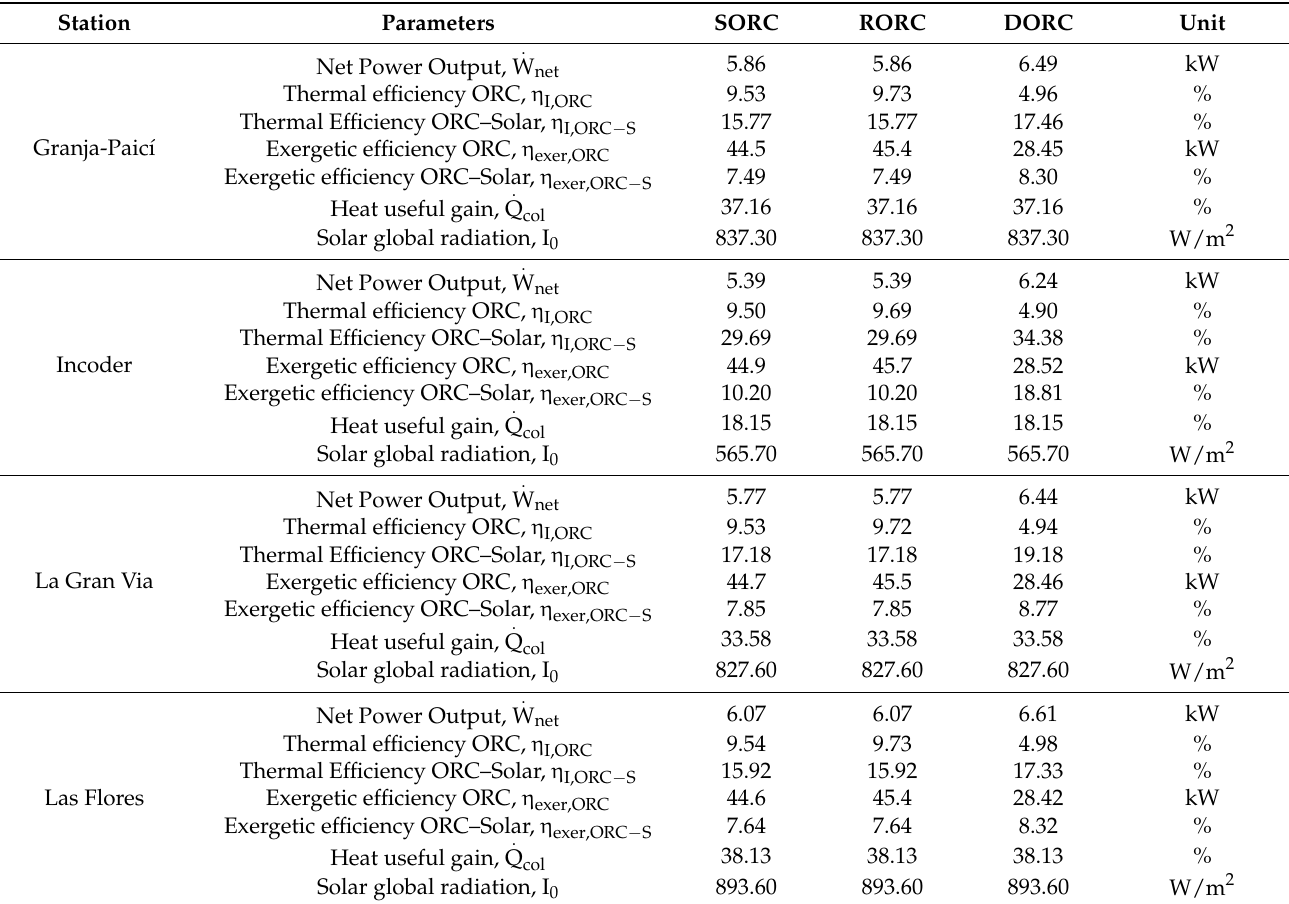
Table 5. Results of the main parameters considered in the study.